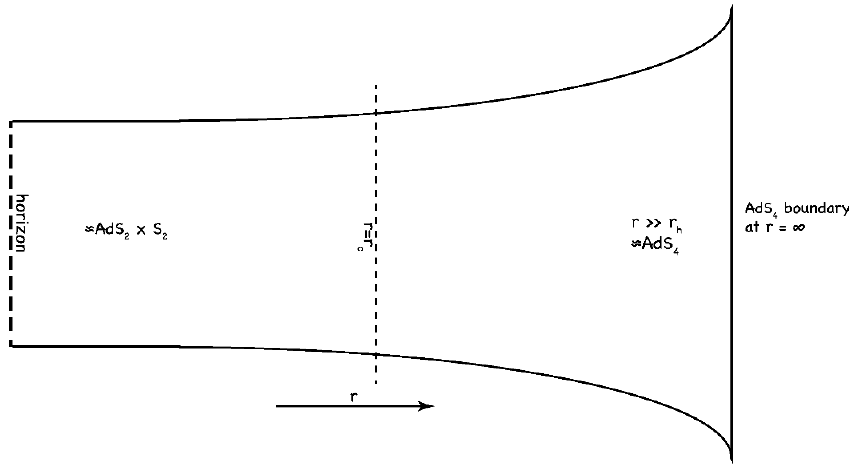
Figure 1 . The near-extremal geometry. For r ! 1 the geometry is asymptotically AdS 4 . r ! r c , where r c (cid:0) r h (cid:28) 1, r c (cid:0) r h (cid:29) 1, is the asymptotic AdS 2 (cid:2) S 2 region. The horizon at extremality is r h L at r = r h